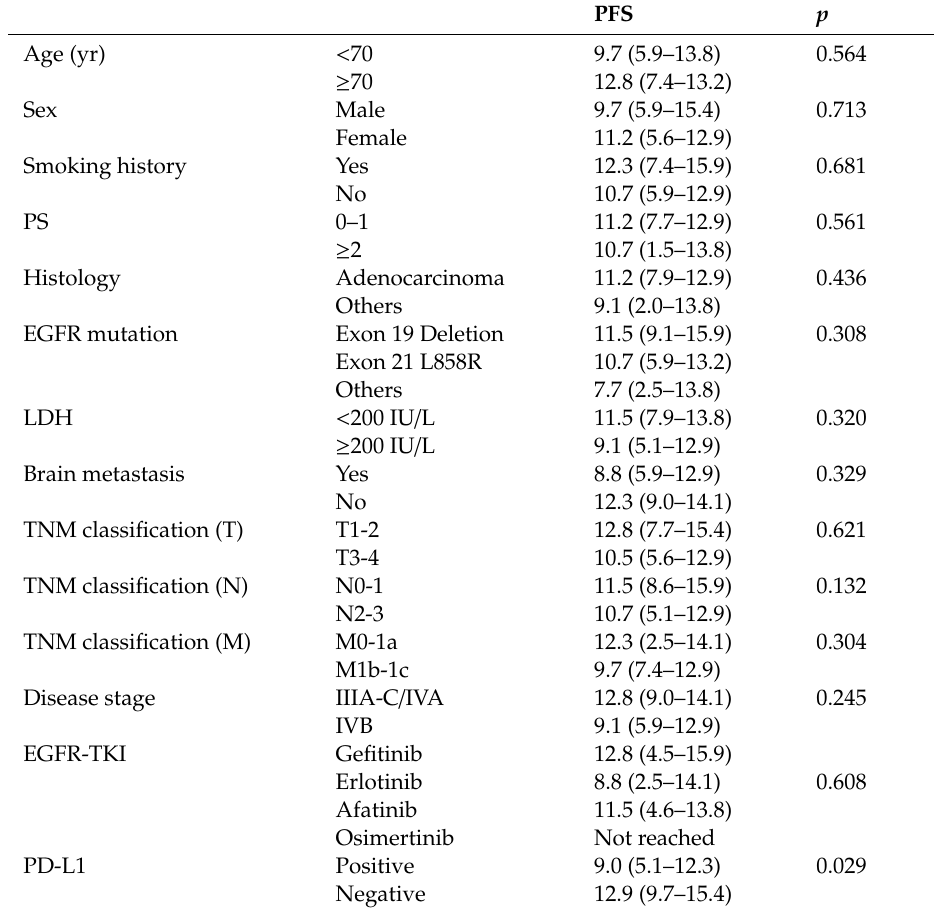
Figure 2. Kaplan-Meier curve for PFS after the initiation of first-line EGFR-TKI treatment in patients with and without tumor PD-L1 expression. Solid line: Patients with negative tumor PD-L1 expression; dashed line: Patients with positive tumor PD-L1 expression. The PD-L1-negative patient group showed a longer PFS than the PD-L1-positive patient group ( p = 0.029, log-rank test). Table 2. Associations of the patient characteristics with the PFS (log-rank test) .